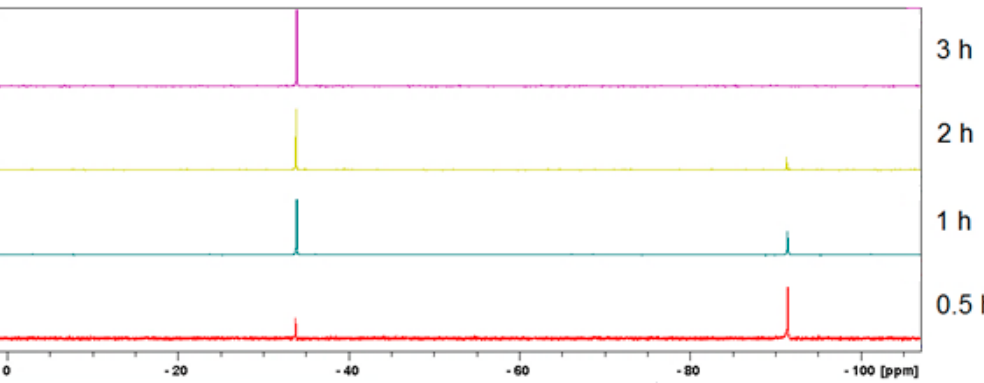
Figure 2. Evolution in time of the 31 P NMR spectra of aqueous reaction mixtures containing equivalent amounts of PTA and trans -glutaconic acid. Conditions : PTA (157 mg, 1.0 mmol), trans -glutaconic acid (130 mg, 1.0 mmol) in 2.5 mL water, T = 70 °C.